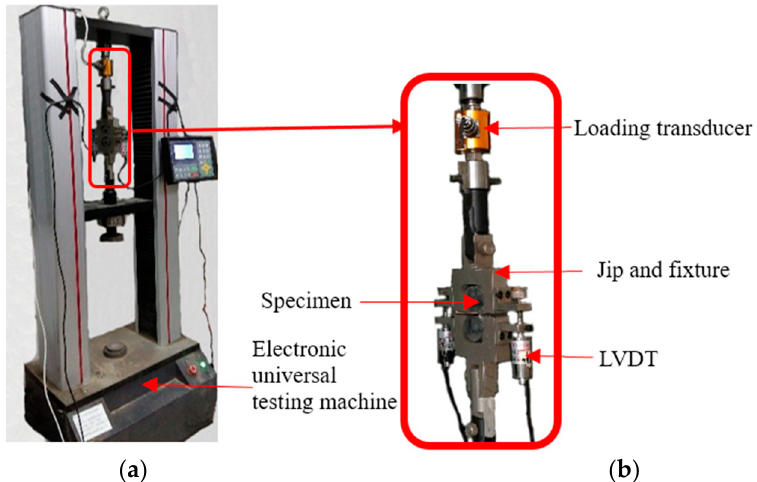
Figure 5. Detailed test devices: ( a ) testing machine; ( b ) pull-out test devices.